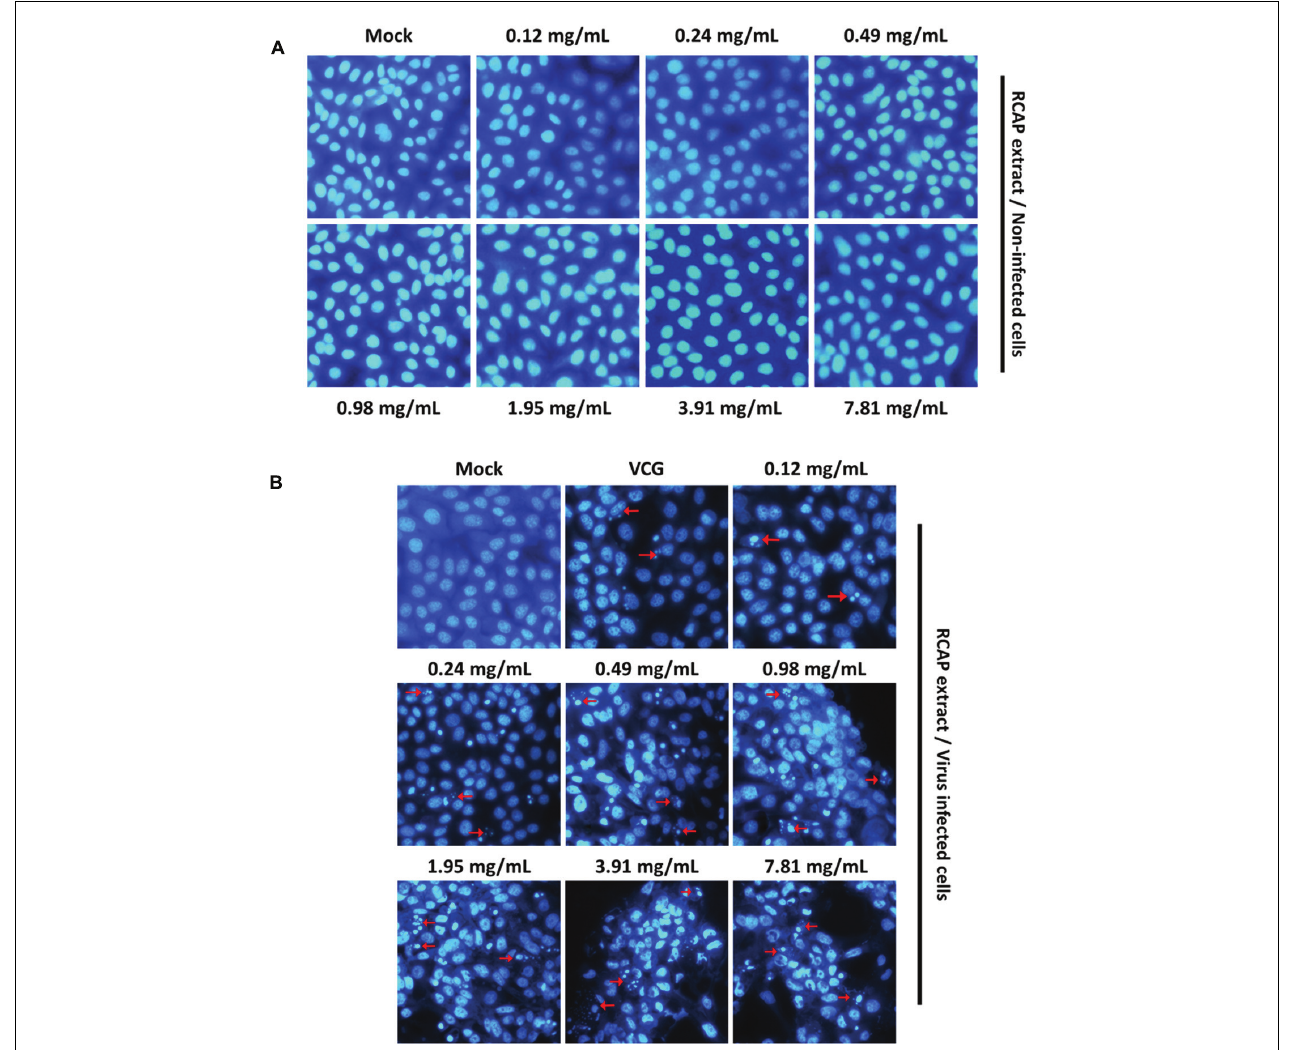
FIGURE 5 | Characteristic nuclear fluorescence of MA-104 cells with DAPI staining. (A) Non-infected cells being treated with different concentrations of RCAP extract; (B) Rotavirus-infected cells being treated with different concentrations of RCAP extract. Red arrows correspond to nuclear fragmentation of apoptotic